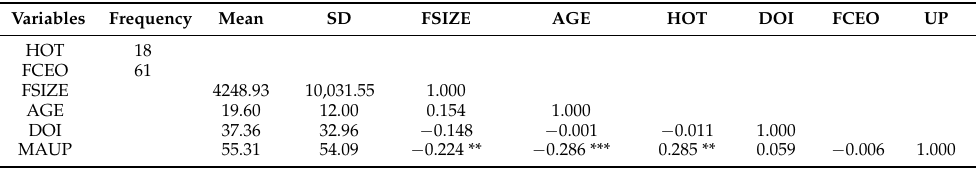
Table 6. Means, standard deviations, and correlations among all